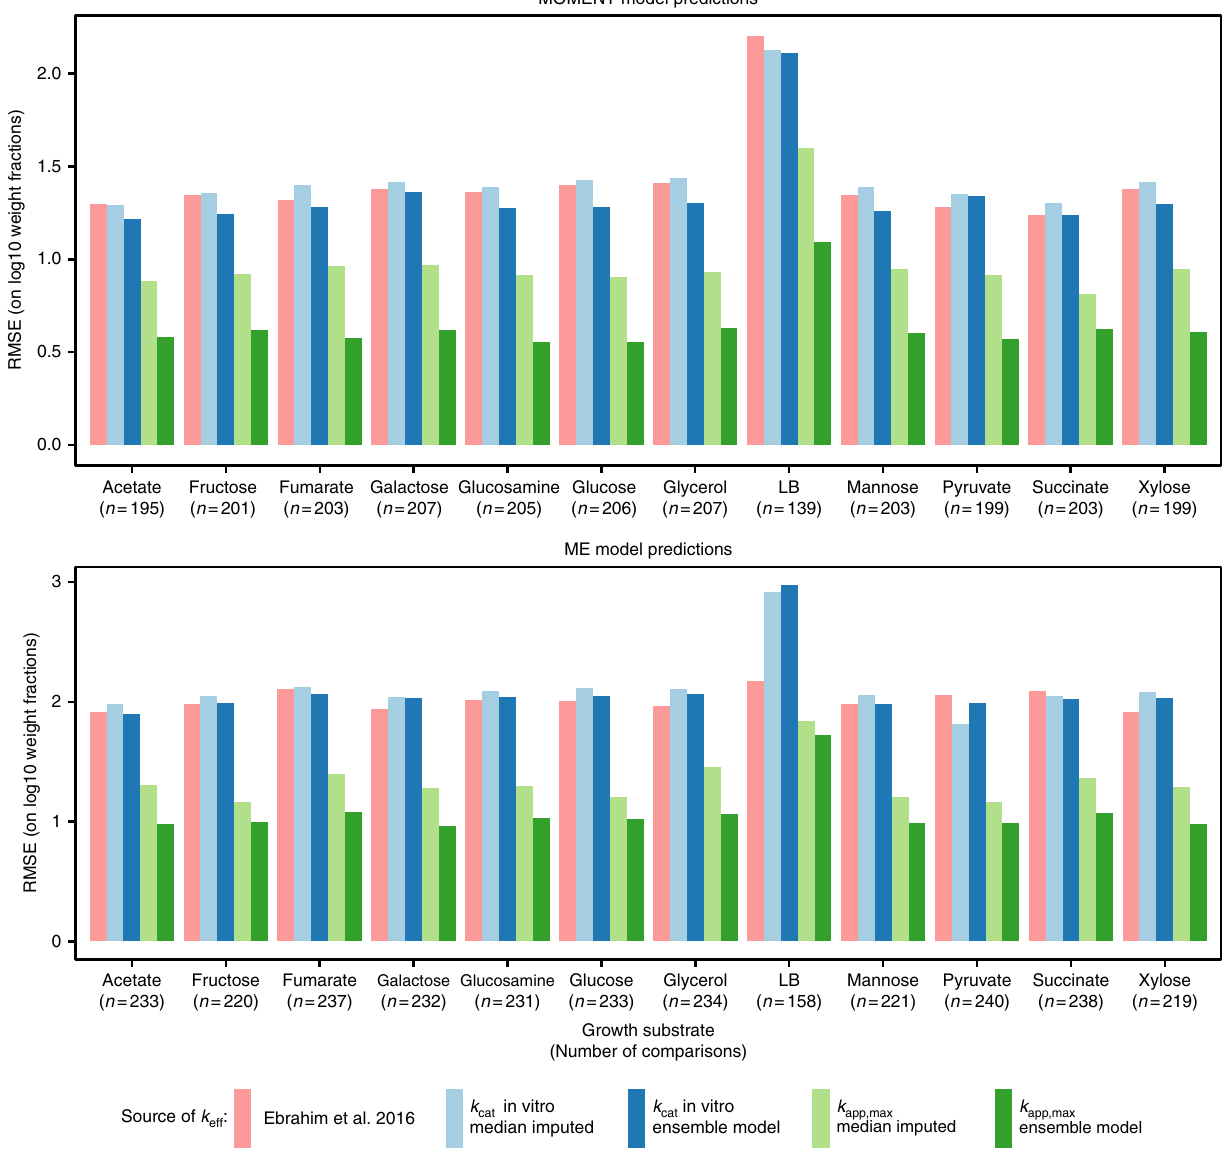
Fig. 4 Performance of vectors of catalytic turnover numbers in predicting quantitative proteome data. Performance for two different genome-scale metabolic modelling frameworks, MOMENT and the ME model, are shown. Model predictions are compared to quantitative proteomics data in Schmidt et al. 37 through the root mean squared error (RMSE) for metabolic proteome fractions on log10 scale. Comparisons use proteins that are both found in proteomics data and are expressed in the model predictions. To allow comparison of different parameterization strategies, the intersection of the sets of comparable proteins is used in each condition-model combination resulting in the number of comparisons n . The performance of the two modelling frameworks, MOMENT and ME, is thus not comparable, as different sets of proteins are underlying the error calculations. See Methods and